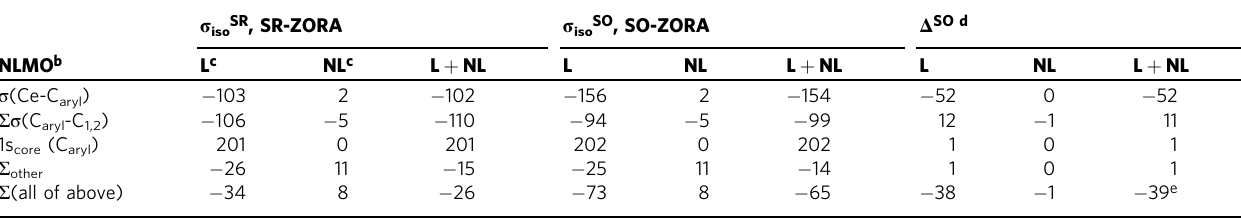
Table 2 NLMO contributions to the 13 C isotropic nuclear shielding ( σ iso ) in 3 a . σ SR , SR-ZORA σ iso